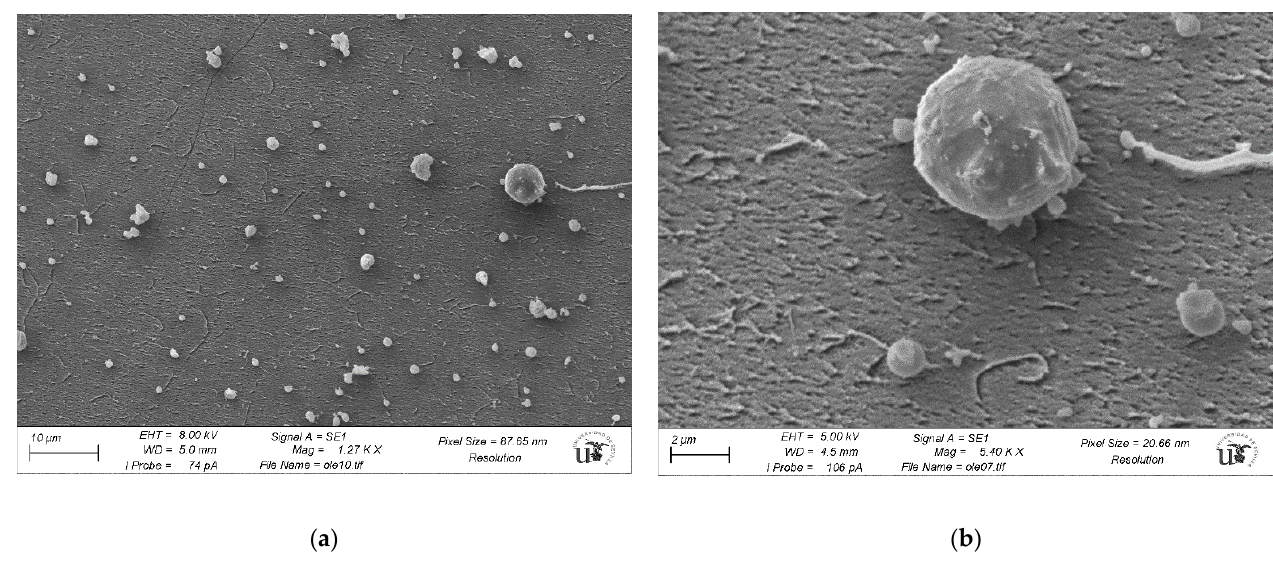
Figure 9. CrioSEM imaging for a solution of [OLE] = 1 × 10 − 4 M in water. Left image ( a ) shows a general view, while the right image ( b ) shows the vesicles at a higher magnification. Background noise was due to ice crystal formation.